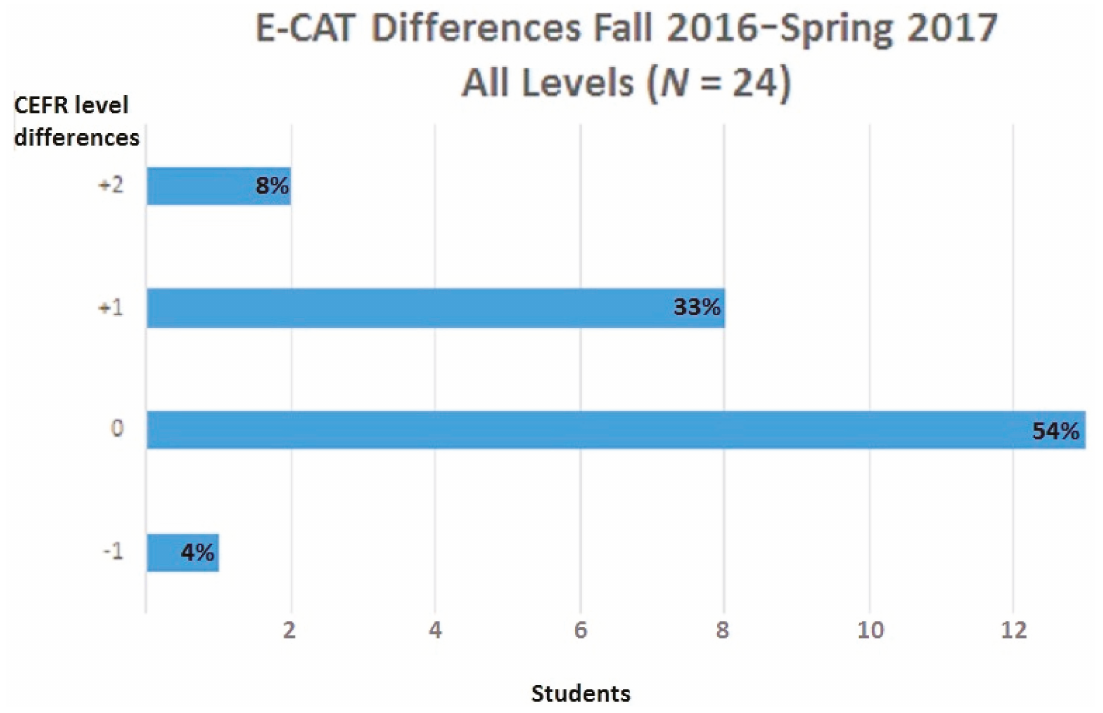
Figure 5. Differences in E-CAT results all levels Fall 2016–Spring